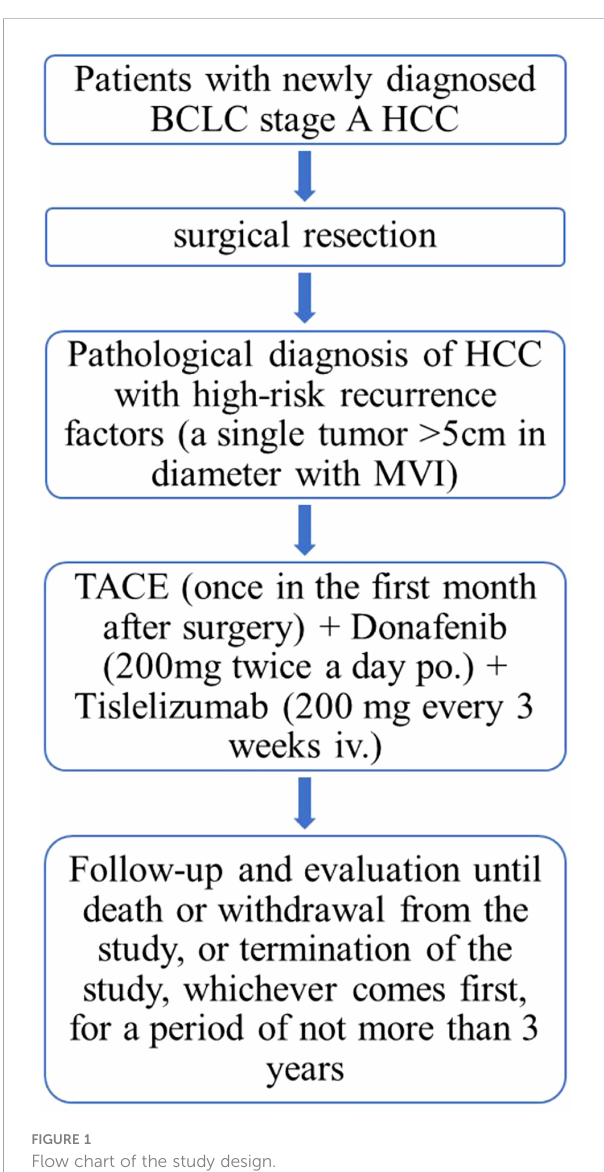
FIGURE 1 Flow chart of the study